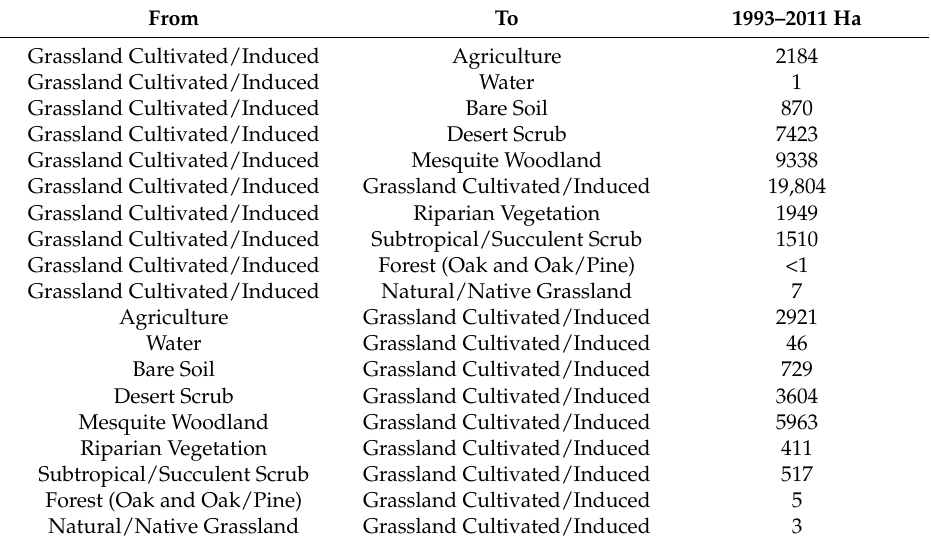
Table 7. Land cover trends relative to the Cultivated/Induced Grasslands class along the 5 km buffer in both